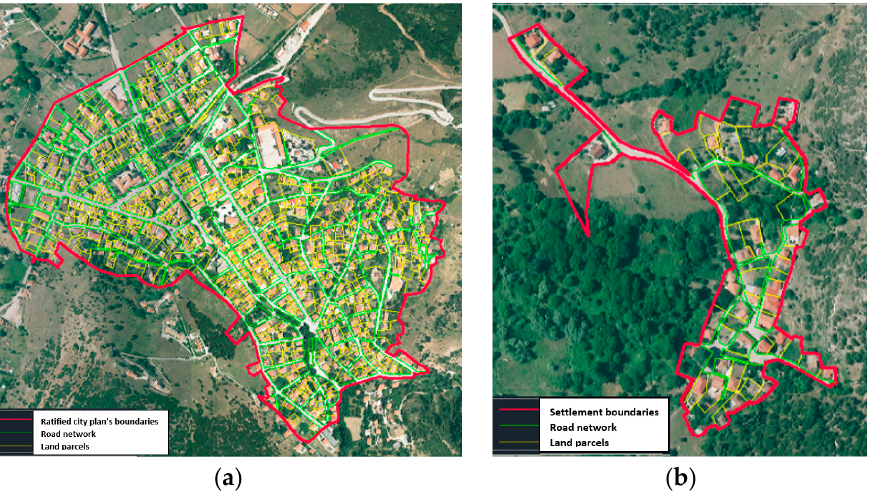
Figure 7. ( a ) Digitization of the obvious preliminary land parcels on the orthophoto within a ratified city plan and ( b ) within an unplanned settlement. Source: [35].